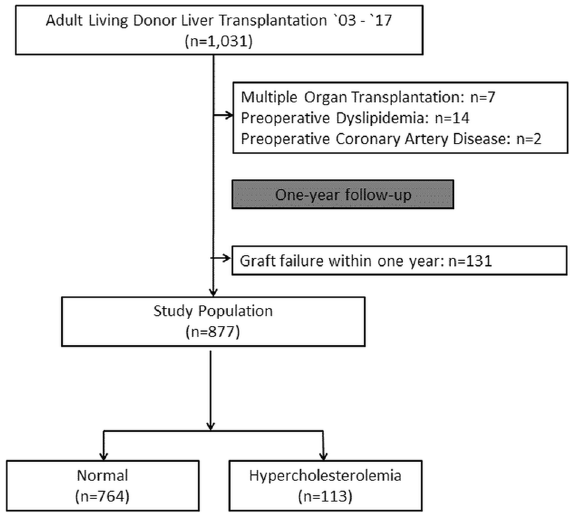
Figure 1. Flowchart of the